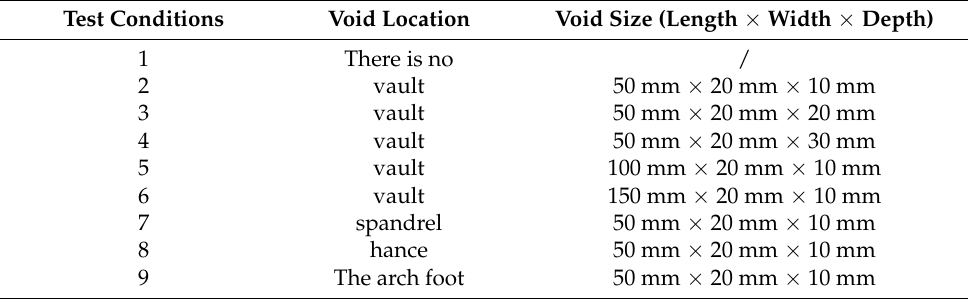
Table 4. Test conditions for the void behind the